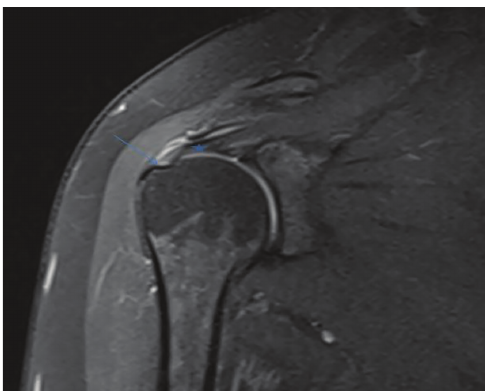
Figure 1a. - 46-year-old female patient. The shoulder MRI performed for shoulder pain shows a moderate partial tear in the supraspinatus tendon on the bursal surface (thin blue arrow). It was observed in more than half the thickness of the torn tendon (small blue star) (grade 3).